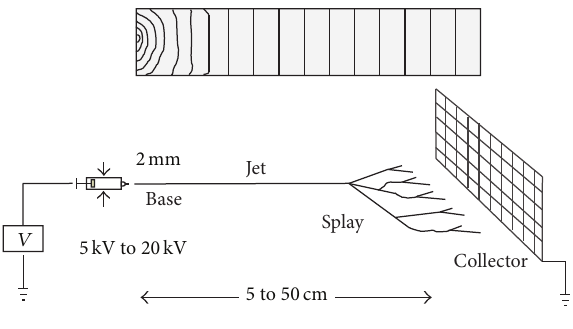
Figure 2: Electrospinning